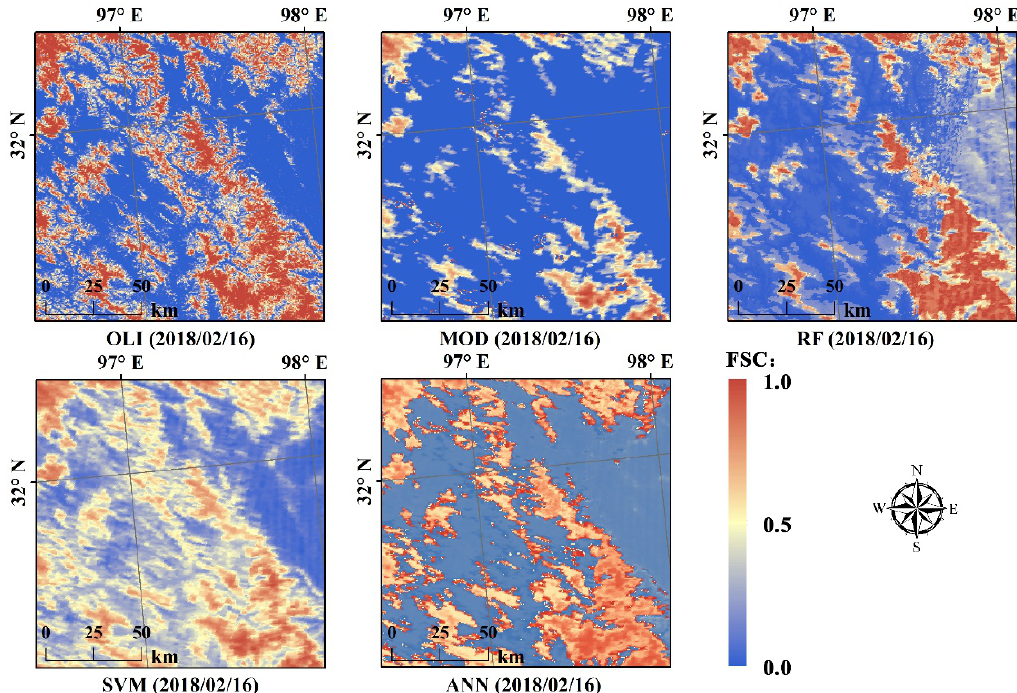
Figure 4. FSC mapping comparison among five algorithms retrieved from the Landsat OLI (OLI), MOD10A1 (MOD) and random forest (RF), support vector machine (SVM) and back-propagation artificial neural network (ANN).